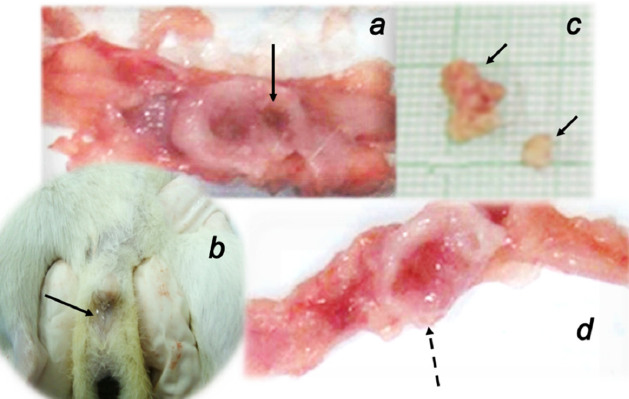
Figure 2. Gross presentation of rats with vesicovaginal fistulas. Bladder presentation and lesion (defect) ( a ), urinary leaking through the vagina ( b ), vesical stones ( c ) (full arrows) always noted in all control rats. These disturbances were absent in rats treated with BPC 157 regimens presenting with the preserved bladder presentation ( d ) (dashed arrow).